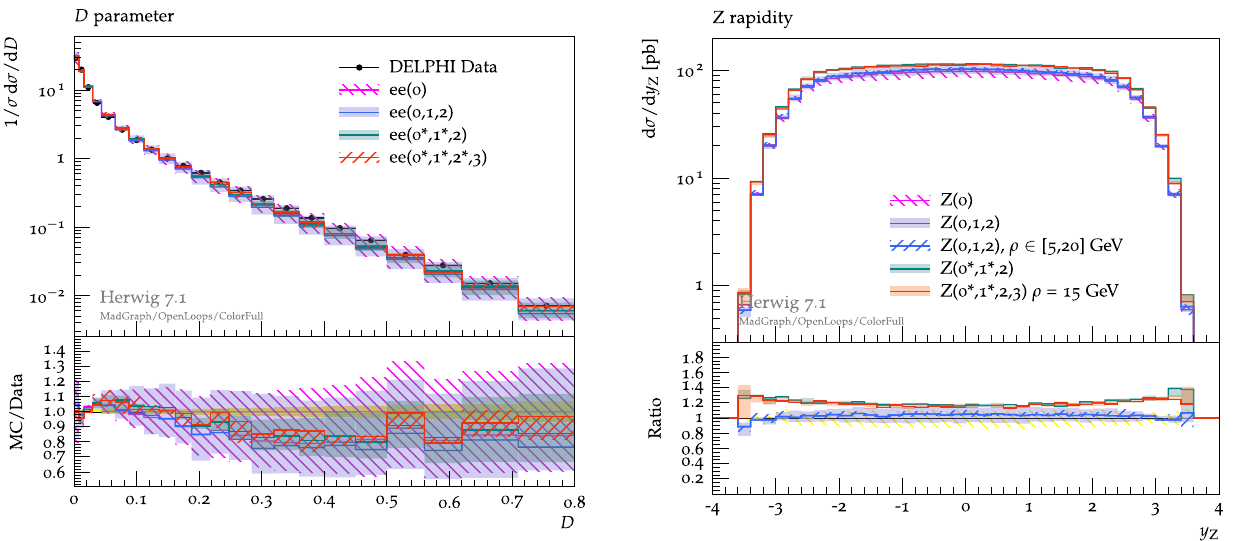
Fig. 21 As an example for unitarized cross sections, we show the rapidity of the Z 0 boson for LO- and NLO-merged samples. The slight increase of the cross section with two additional hard jets is due to the non-unitarization of unordered